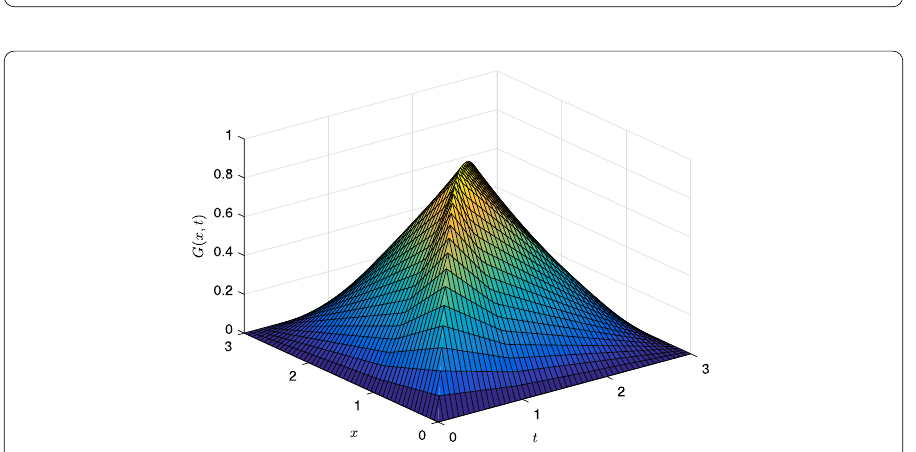
Figure 5 Local Green functions for κ ( x ) in Eq. (6.1) Graphs of the local Green functions ψ i (solid line) and ϕ i (dotted line) in the case of the piecewise constant κ ( x )